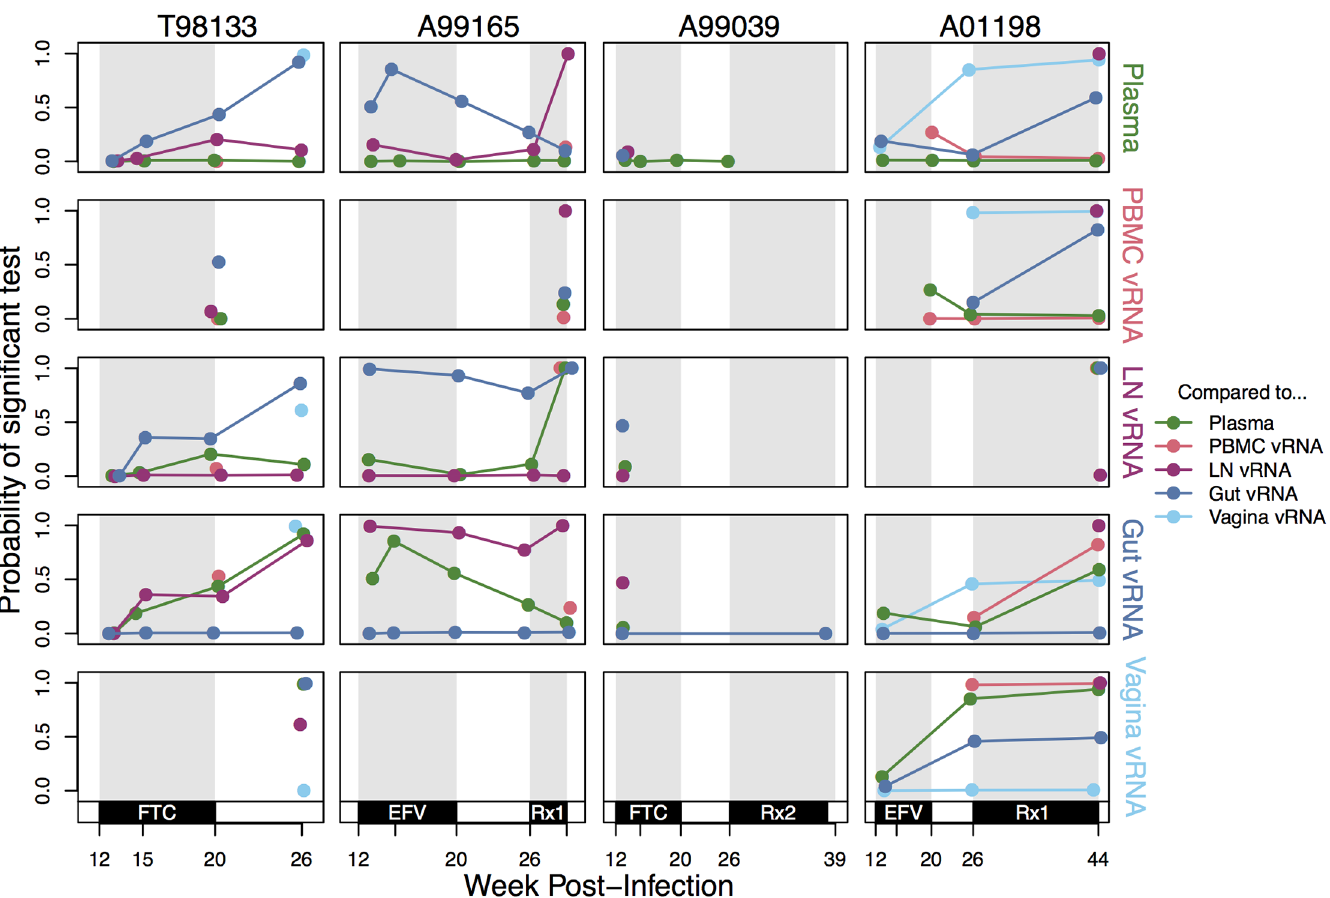
Fig 6. Compartmentalization relationships between different samples reveal transient and stable patterns. Probabilityof a significantpairwise compartmentalization test betweenvRNA subsampled from each compartment for the four macaques(columns)over time (x-axis). Each row represents comparisons between the vRNA in each compartment marked at the right (from top to bottom: plasma, PBMC, LN, gut and vagina vRNA) to all other compartments. Becauseall pairwiserelationshipsare shown for each compartment, lines are repeated(i.e., the lymph node versus plasma line is present in both the lymph node and plasma rows). The y-axis indicatesthe proportionof K ST tests significantat the 5% significancelevel when subsampledto 10 sequencesper compartment 1000 times. Coloration indicatesthat the comparisonwas done betweenthe focal compartment for the row and plasma (green), PBMC (pink), LN (purple),gut (dark blue) or vagina (light blue). Rx1 is treatment FTC+TFV+EFV and Rx2 is the treatment TFV+L870812+DRV/r.